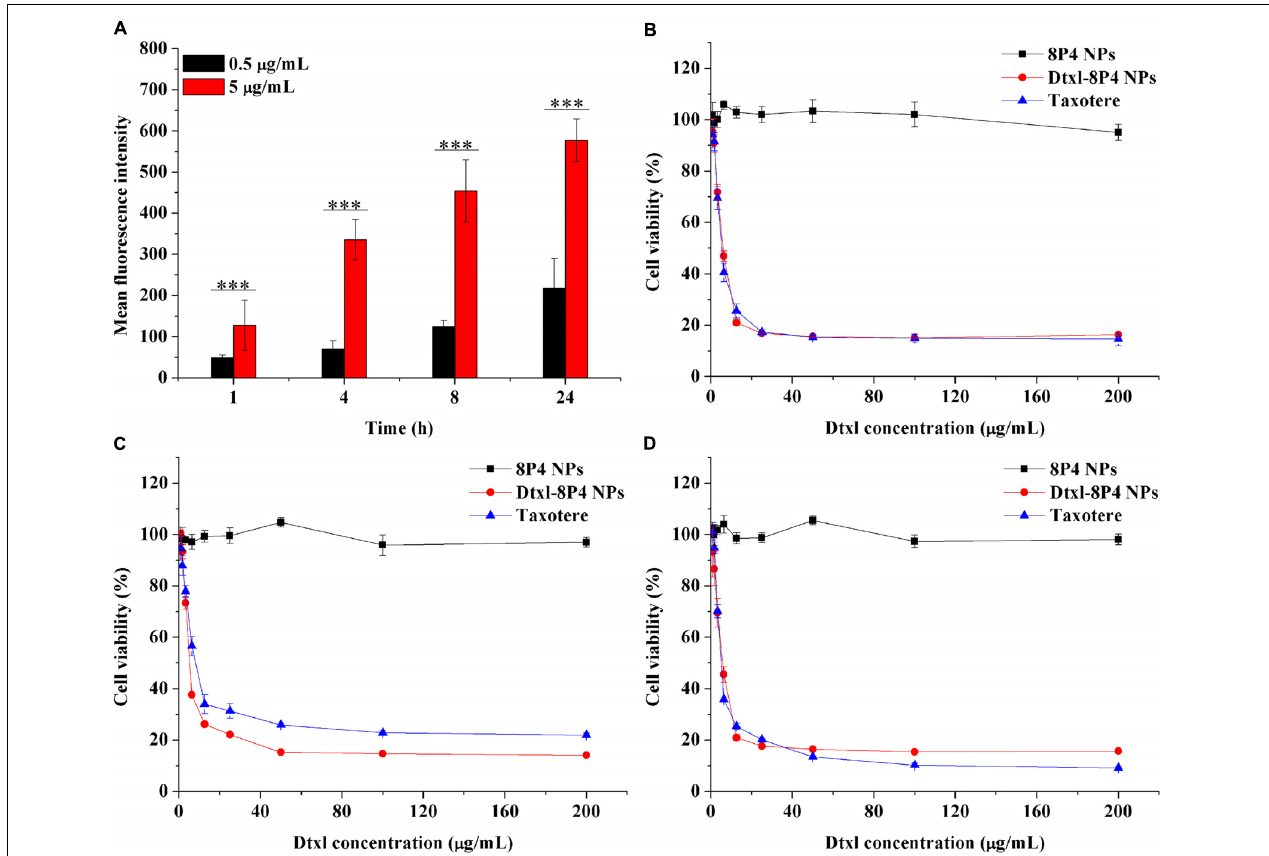
FIGURE 4 | (A) Fluorescence intensity of A549 cells incubated with Dil-8P4 NPs. (B–D) Cytotoxicity of Dtxl-8P4 NPs and Taxotere against (B) A549, (C) DU145, and (D) PC3 cells after exposure for 48 h.